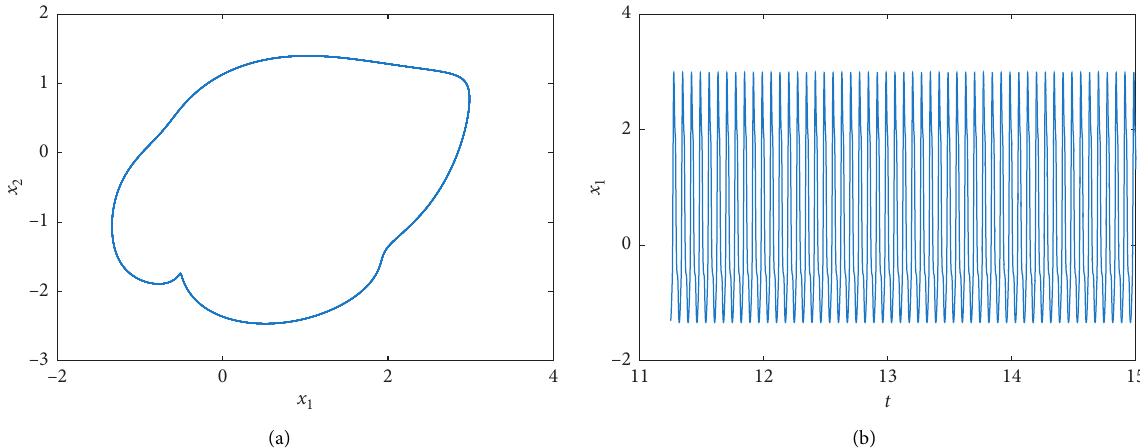
Figure 10: Phase portrait on plane ( x motion when P